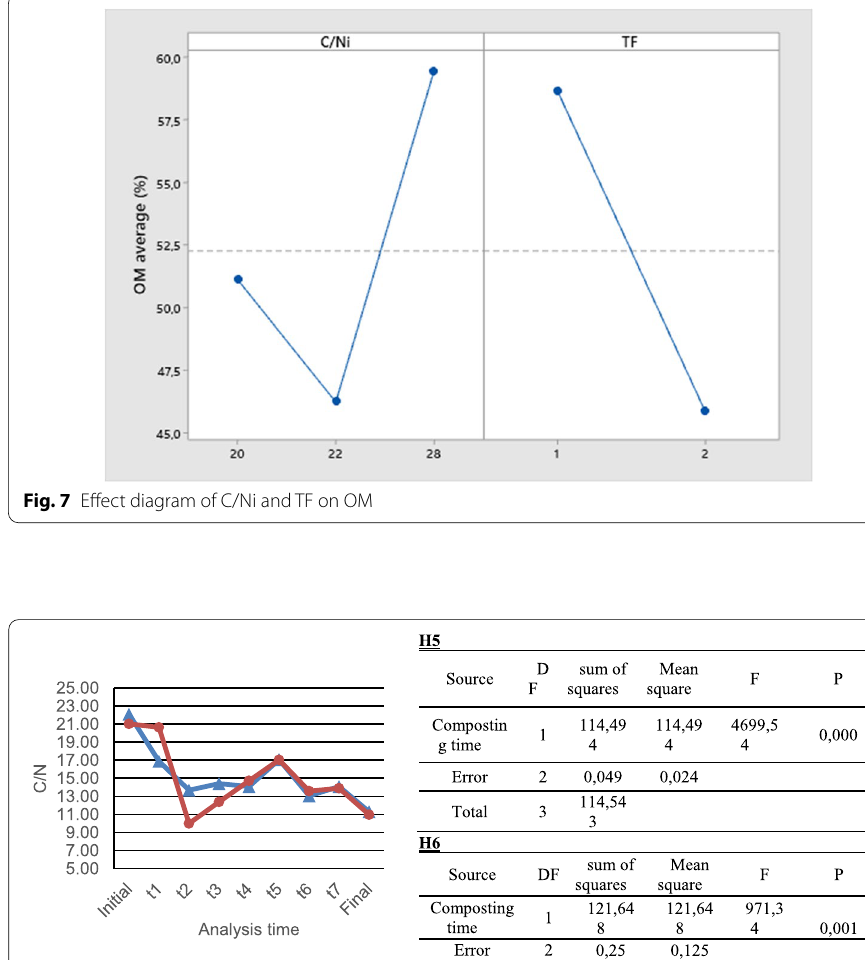
Table 11 ANOVA test associated with C/Ni and TF effects on C/N Source